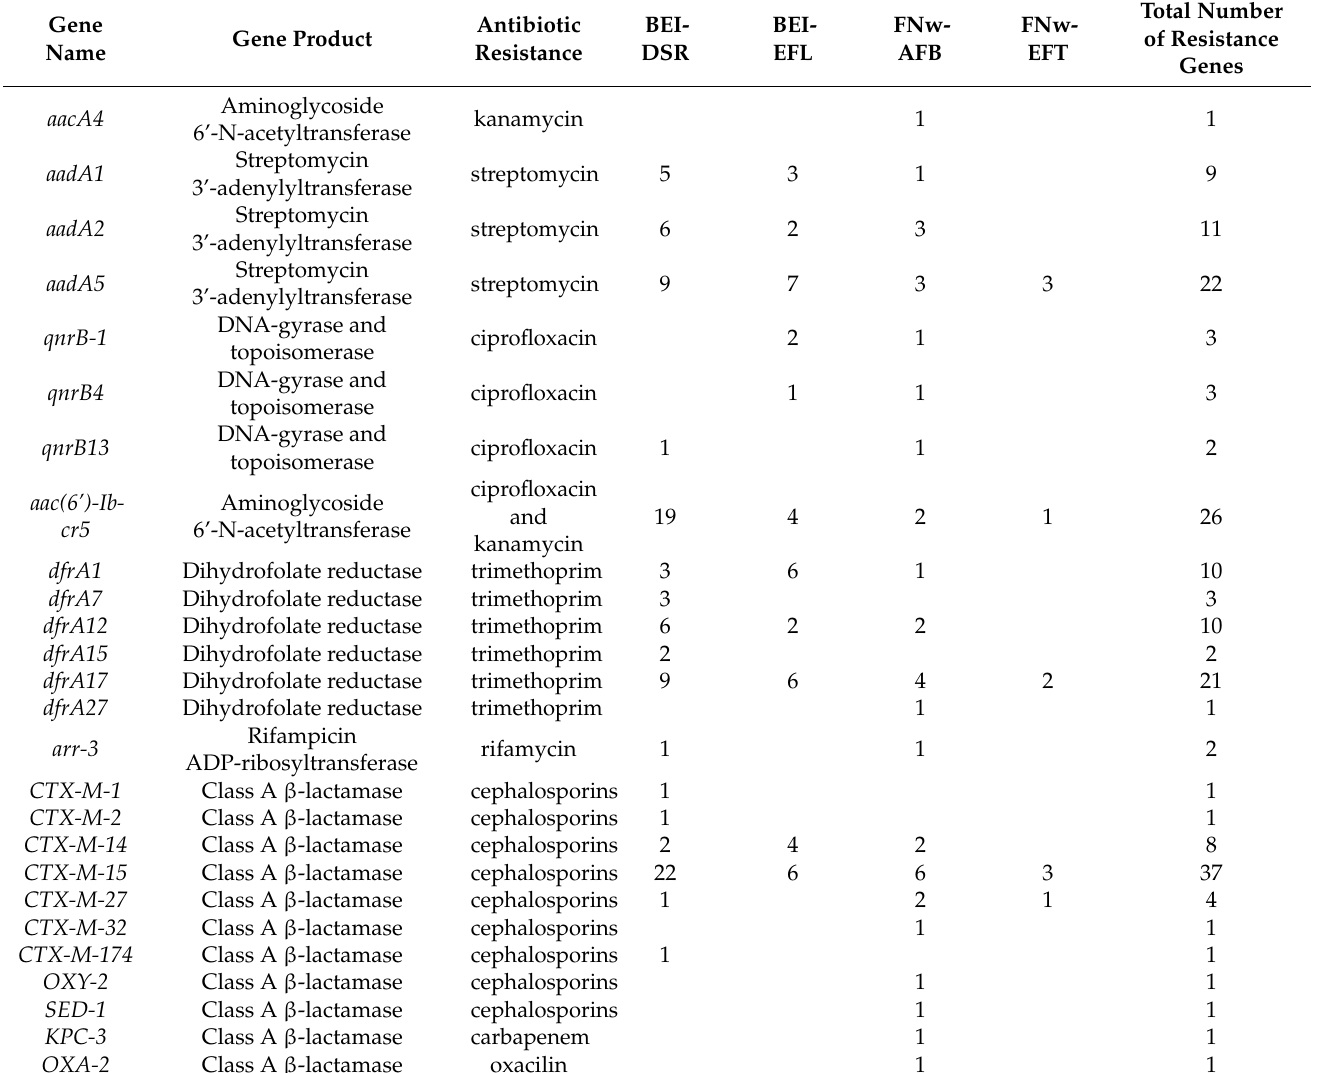
Table 1. Distribution of 183 resistant genes identified in wastewater isolates from the Beirolas (BEI-DSR/EFL) and Faro (FNw-AFB/EFT) WWTPs ( n =